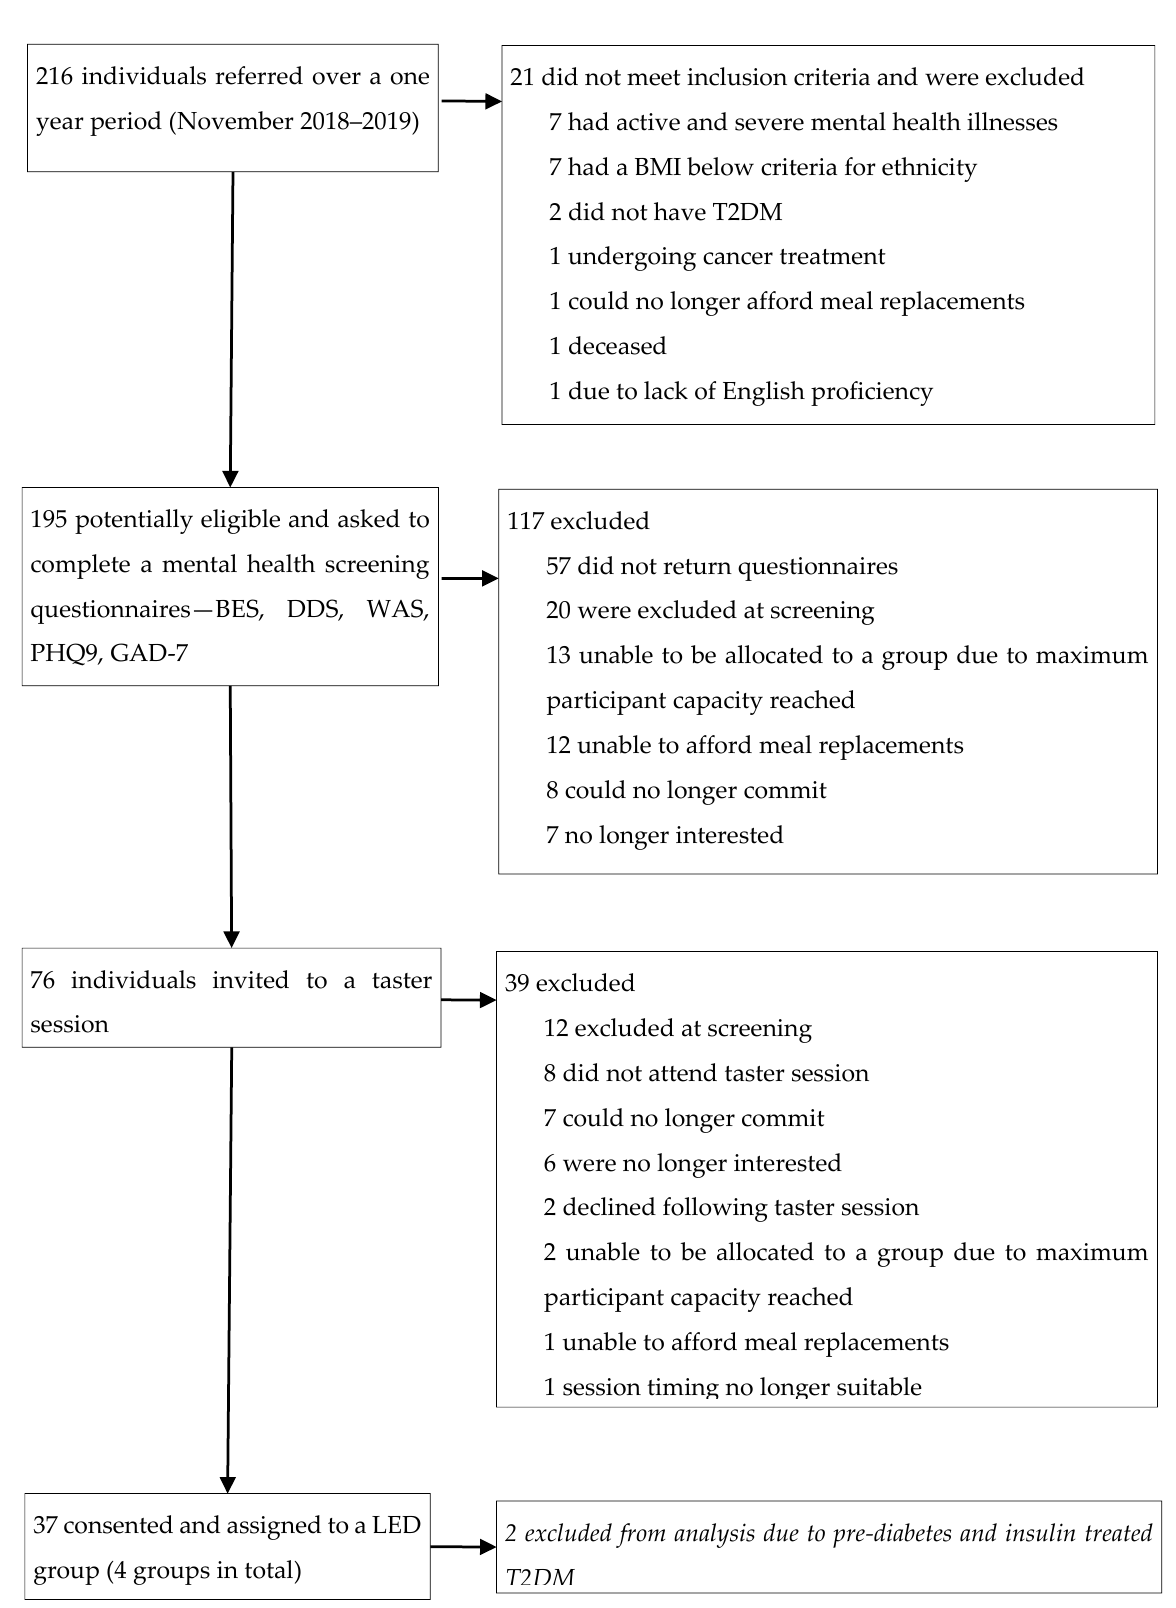
Figure 1. Trial profile. BMI, body mass index, T2DM; type 2 diabetes mellitus; DDS = Diabetes Distress Score. PHQ9 = Patient Health Questionnaire. GAD7 = Generalised Anxiety Disorder Questionnaire. WAS = Work and Social Adjustment Scale. BES = Binge Eating Scale.